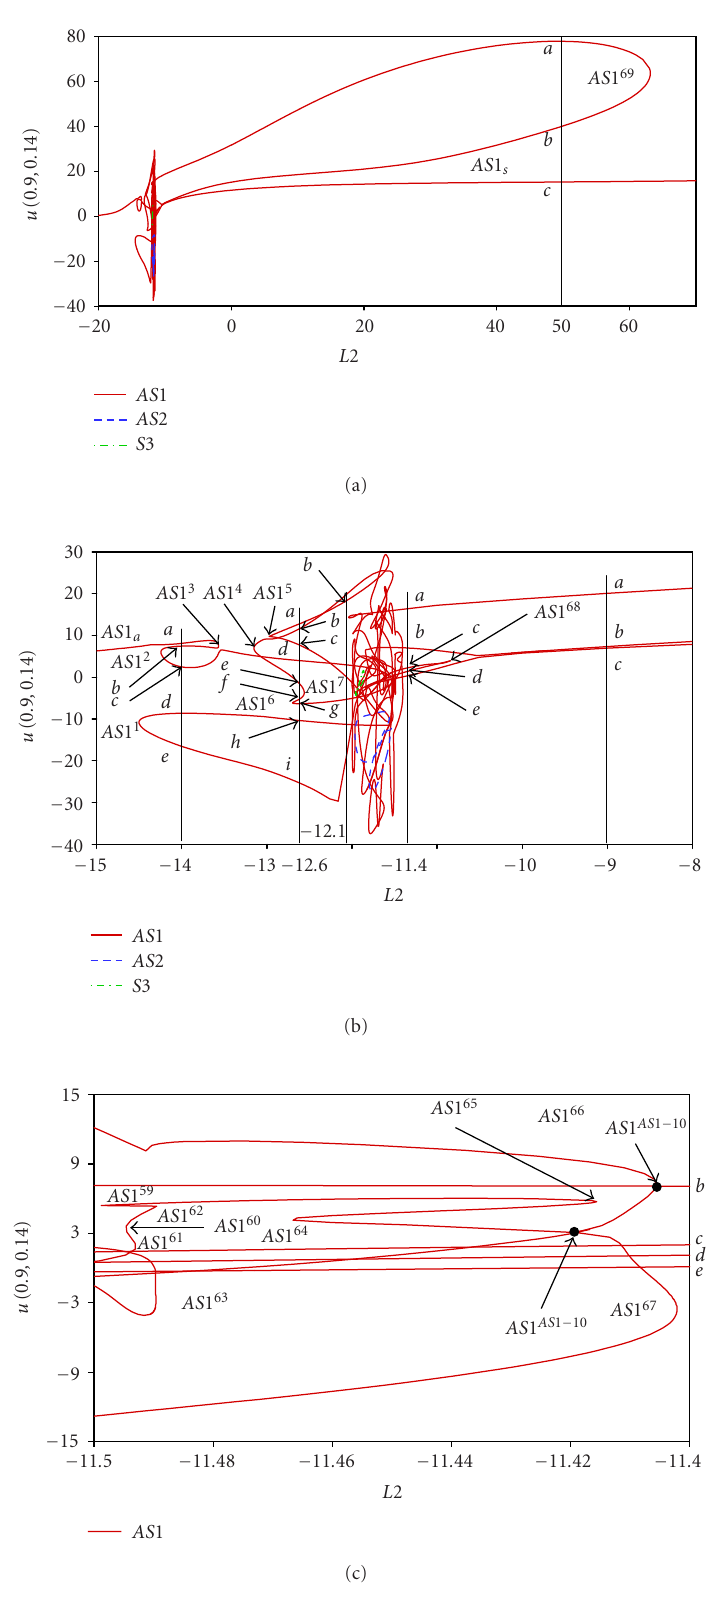
Figure 2: Solution branches and limit/bifurcation points ( σ = 0 . 02, Pr = 0 . 7, Dk = 300, and L 1 = 28): (a) − 20 < L 2 < 70; (b) − 15 < L 2 < − 8; and (c) − 11 . 5 < L 2 < − 11 .